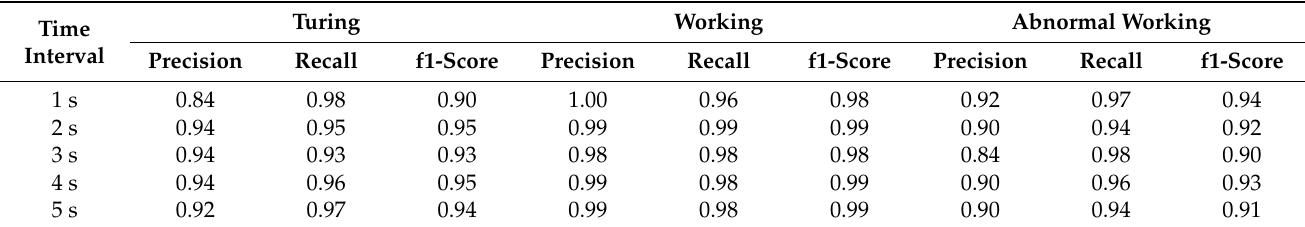
Table 2. Comparison of algorithm results for trajectory data at different time